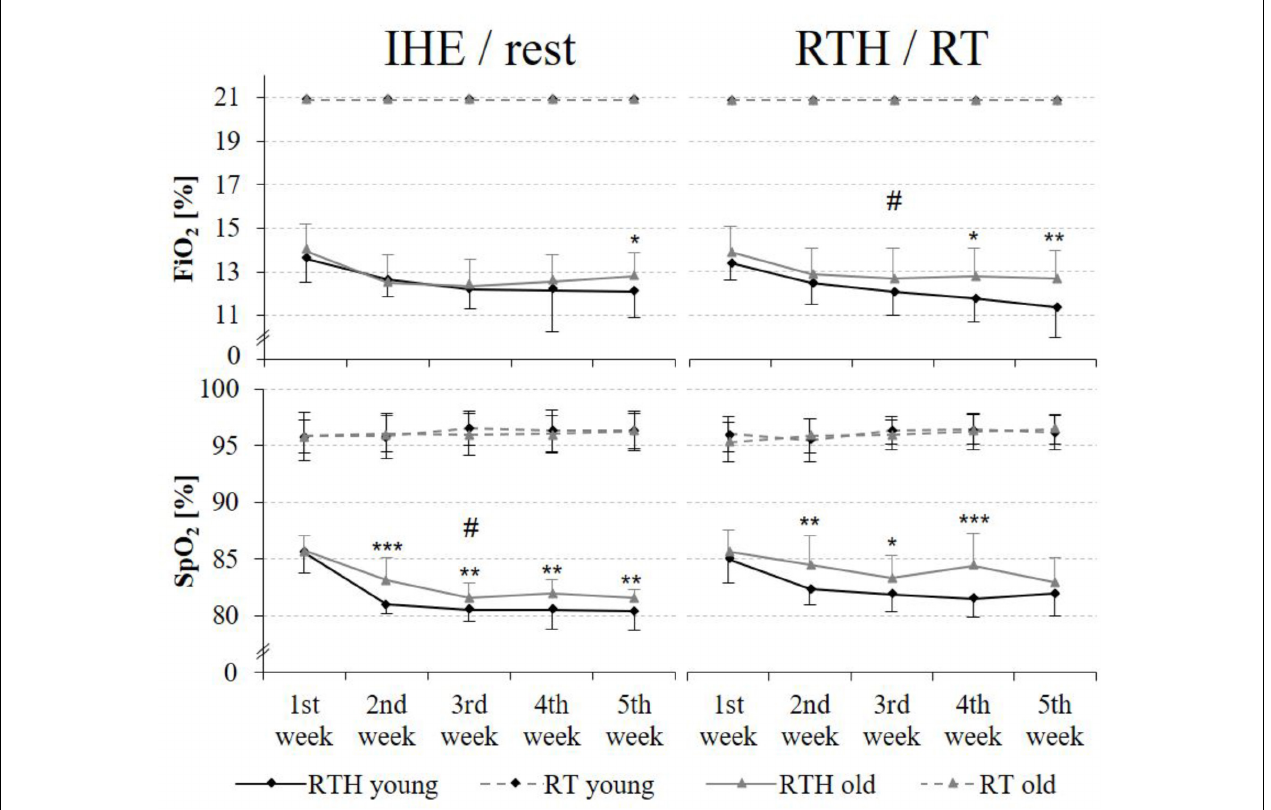
FIGURE 4 | External [fraction of inspired oxygen (FiO 2 )] and internal [oxygen saturation of the blood (SpO 2 )] hypoxic intensity during the IHE/rest phase and the RTH/RT phase in each week of the 5-week intervention period; resistance training under hypoxic conditions (RTH), resistance training under normoxic